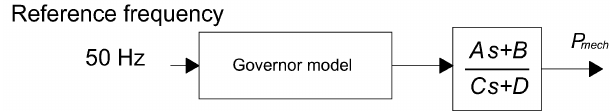
Figure 8. Governor representation for the large grid scale